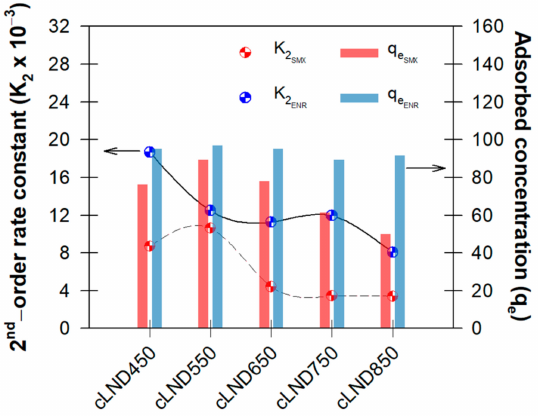
Figure 5. Intraparticle diffusion mechanism plots with varying cLND for ( A ) SMX or ( B )